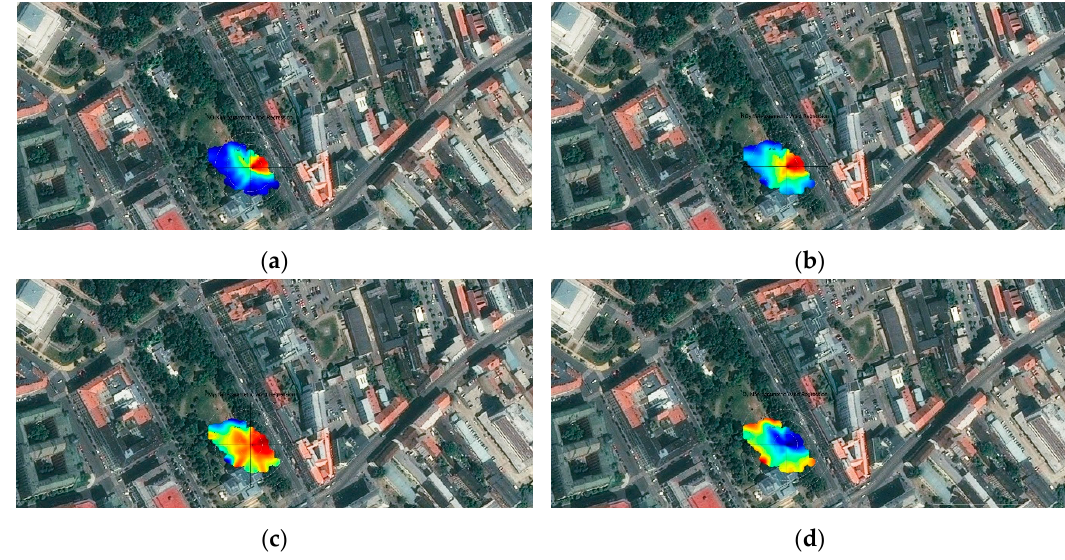
Figure 9. The NO ( a ), NO 2 ( b ), PM 10 ( c ), and O 3 ( d ) concentration relationships to the wind speed and direction at Kolišt ě ; sampling started on 18.1.2019 7:00.